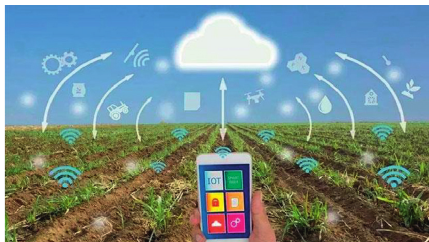
Figure 3: Rural picture of the Internet of Things (picture